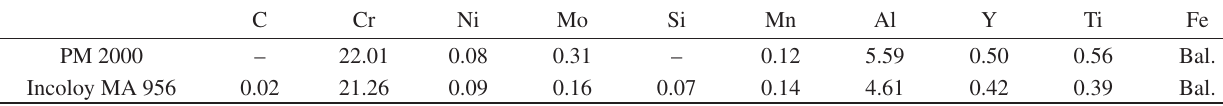
Table 1. Chemical composition ( wt. (%) ) of Incoloy MA 956 and PM 2000. C Cr Ni Mo